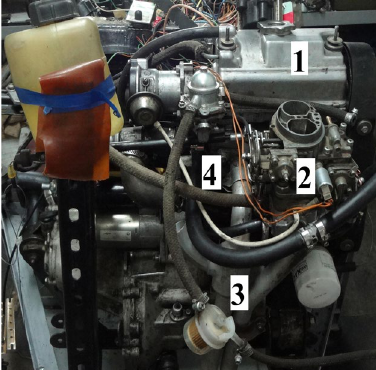
Figure 5. Gasoline engine for verification of laboratory research data and modelling results: 1—engine block head; 2—inlet pipeline; 3—exhaust manifold; 4—cylinder block.